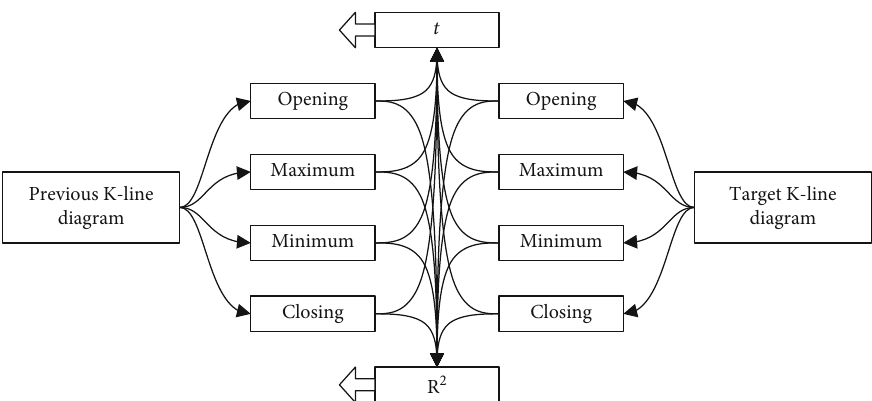
Figure 2: The raw data acquisition mode and analysis results used in this study. Opening & Maximum & Minimum & Closing: initial value, maximum value, minimum value, fi nal value in K-line data; result of t -bivariate t -veri fi cation, and evaluation value of determination coe ffi cient in R 2 regression analysis. Table 1: Relationship between raw data volume and prediction